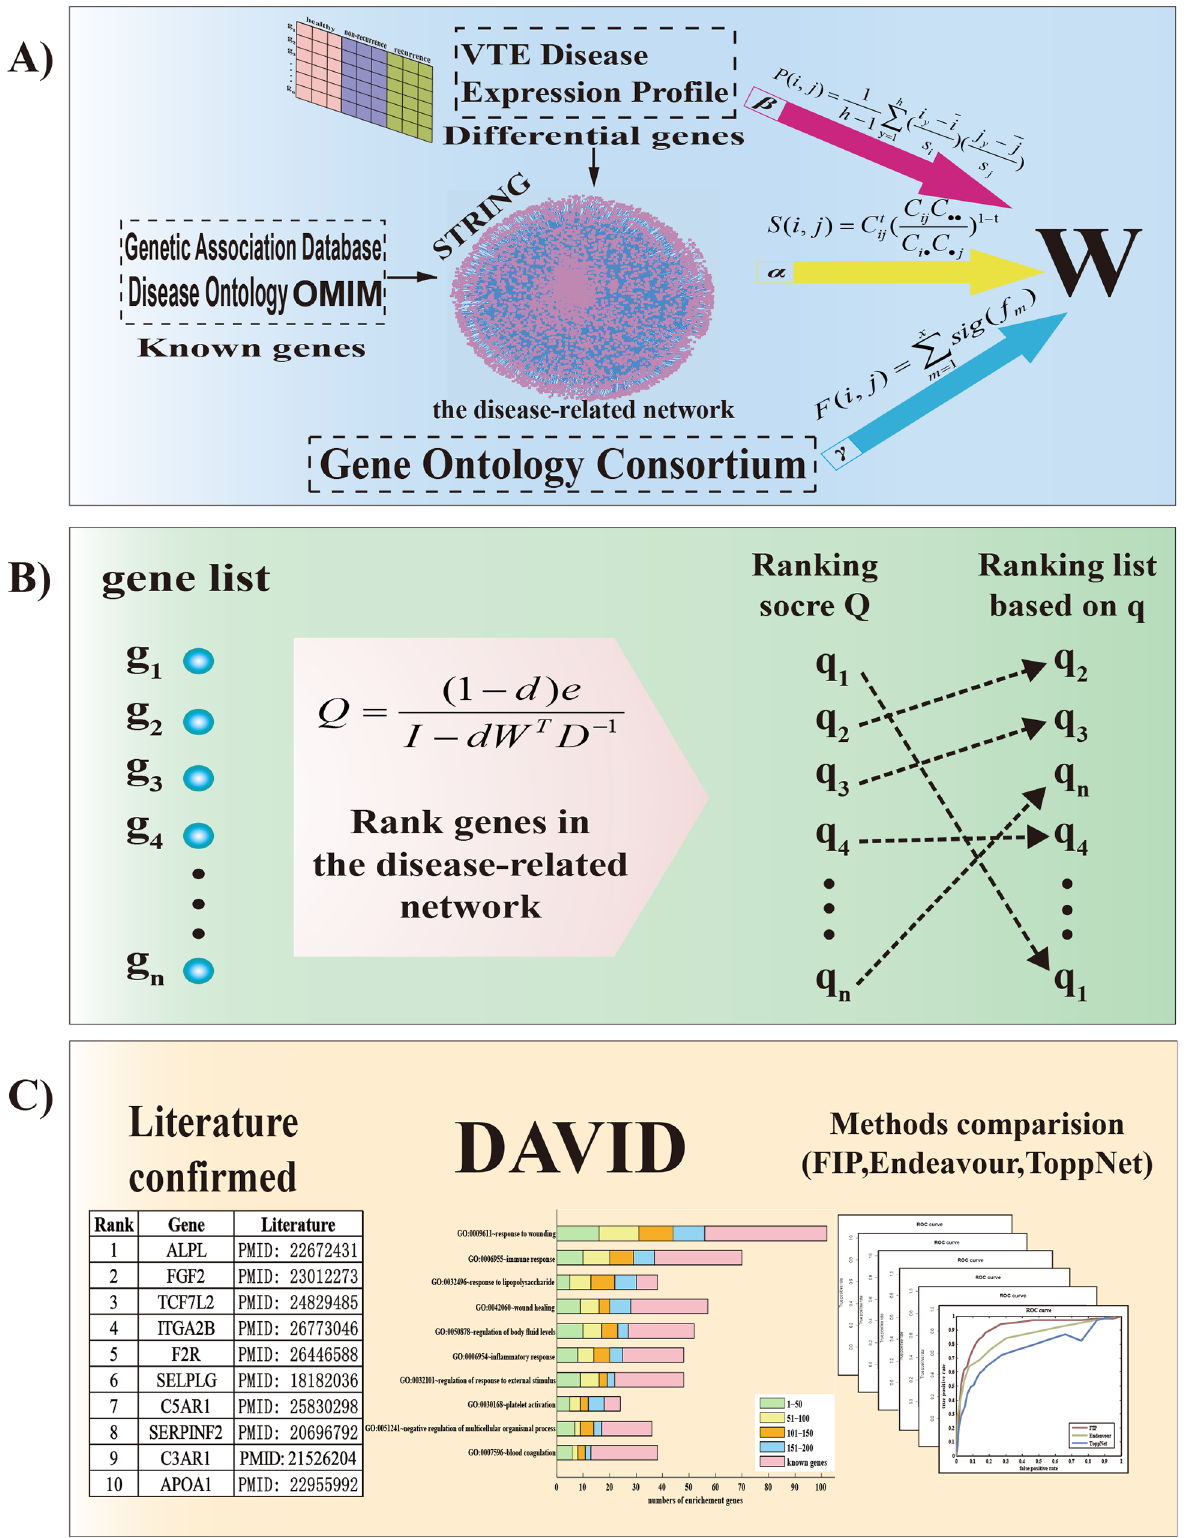
Fig 1. The workflow of FIP method and its validations. A: measurement of the overall similarity between genes. B: calculation of ranking scores of candidate genes. C: verification of the performance of the results. doi:10.1371/journal.pone.0153006.g001 PLOS ONE | DOI:10.1371/journal.pone.0153006 April 6,